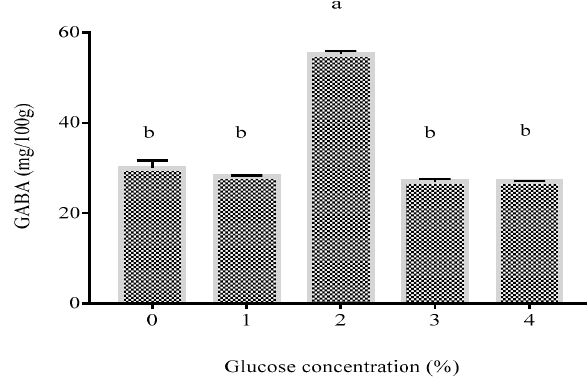
Figure 3. E ff ect of glucose induction at di ff erent concentrations on GABA content of yogurt. Di ff erent Figure 3. Effect of glucose induction at different concentrations on GABA content of yogurt. Different letters indicate a significant di ff erence at p < letters indicate a significant difference at p < 0.05.